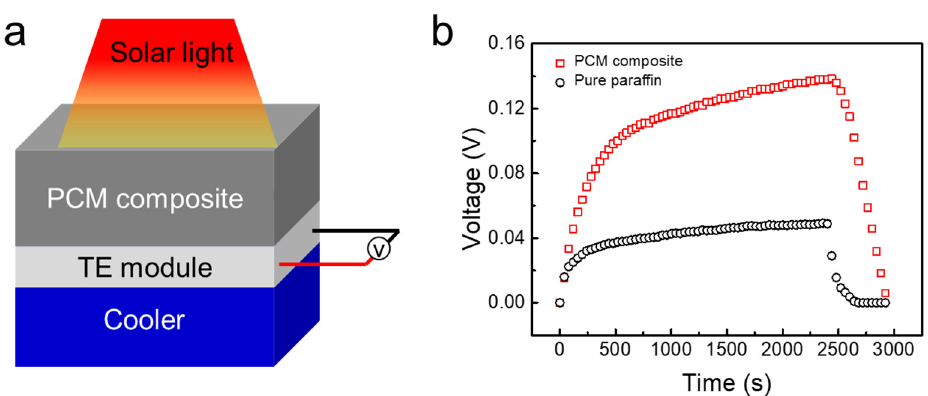
Figure 5. Solar-thermal-electric conversion based on the PCM. ( a ) Schematic illustration of the solar- thermal-electric device based on the composite PCM. ( b ) Open circuit voltage of the thermoelectric module with time under the simulated solar irradiation.